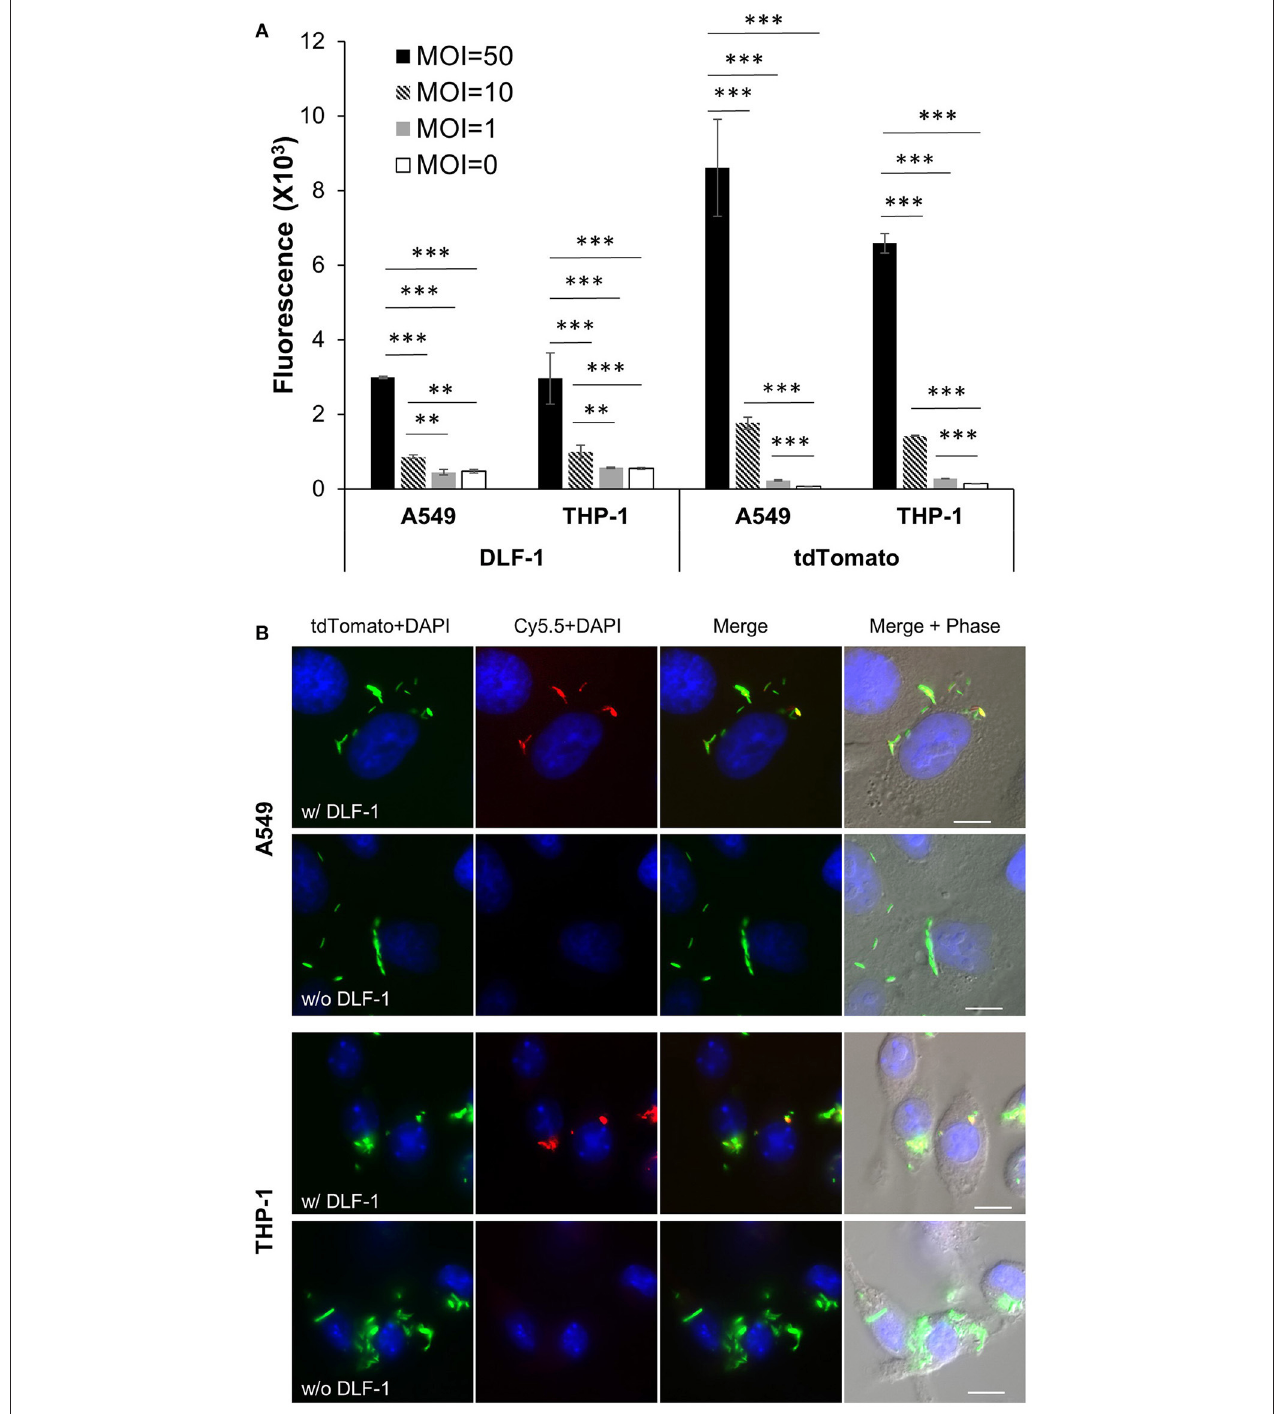
FIGURE 5 | Imaging infection of human epithelial cell line (A549) and human macrophage cell line (THP-1) with DLF-1 (100 nM) labeled Mtb . (A) Fluorescence detected from cells infected with DLF-1 labeled Mtb at different MOIs in vitro . Fluorescent intensities were measured for the labeled DLF-1 (Cy5.5) and for the endogenous fluorescent tdTomato protein, respectively. Error bars represent standard errors of means calculated based on results from three independent experiments. One-way ANOVA test was conducted for assessing overall differences among groups, and Turkey’s multiple comparison tests were applied to assess differences between two groups. ** P < 0.01; and *** P < 0.001. (B) Images of DLF-1 labeled Mtb inside of cells. THP-1 and A549 were infected with a tdTomato-expressing Mtb strain which has been labeled with DLF-1. Red, pseudo-colored DLF-1; Green, pseudo-colored tdTomato; and Blue, DAPI. White scale bars represent 10 µ